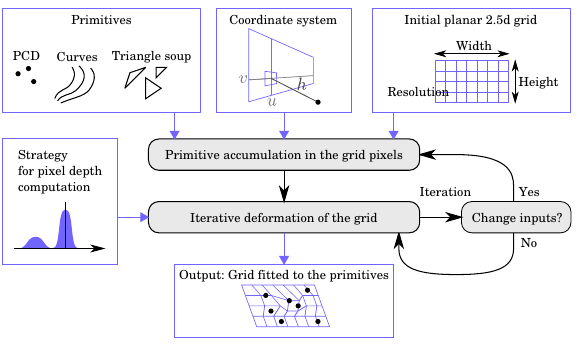
Figure 2: Workflow of grid fitting to the primitives. A 2.5d grid is fitted to the geometrical primitives. In the 2.5d grid coordinate system, any 3d point is defined by u and v that locate the point on the grid, and h that is the depth from the u - v plane. The main steps and the inputs of the algorithm are depicted there- after and in figure